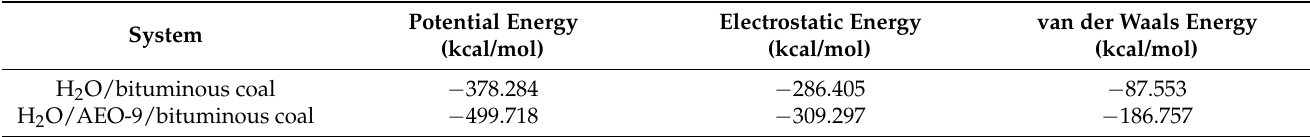
Table 4. The interaction energy of different simulation